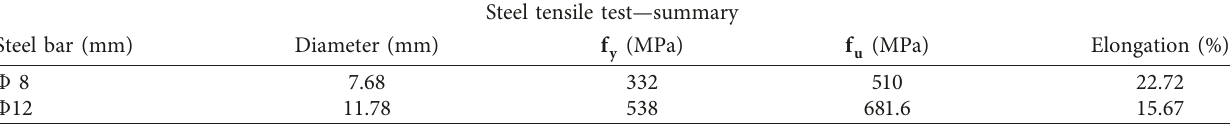
Table 6: Properties of the tested reinforcement bars.